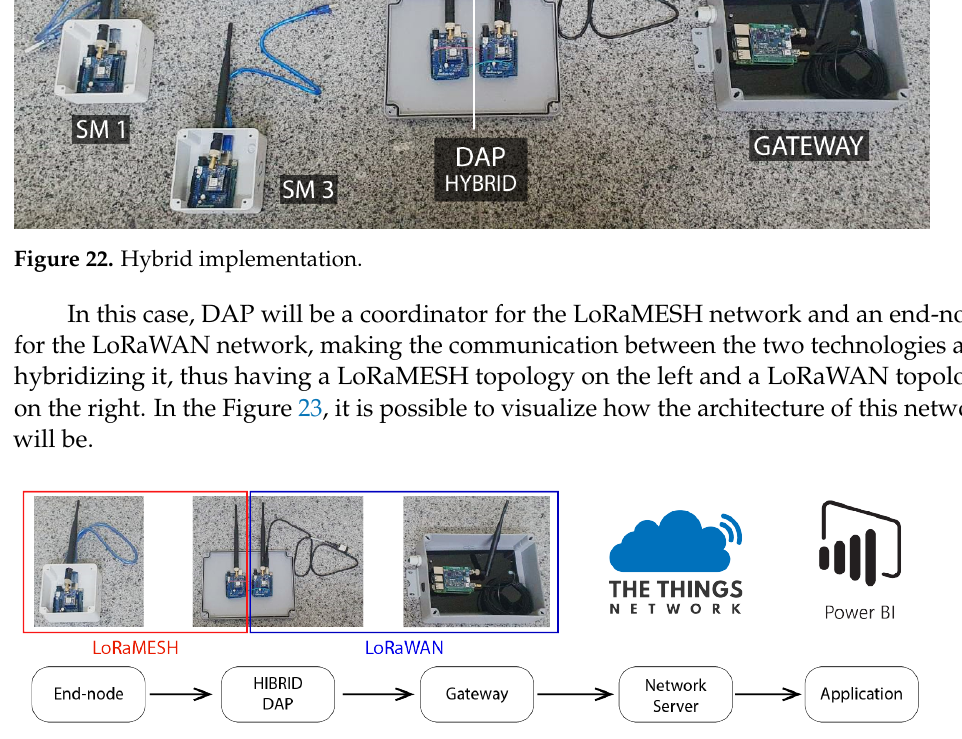
Figure 23. DAP implementation proposal for AMI